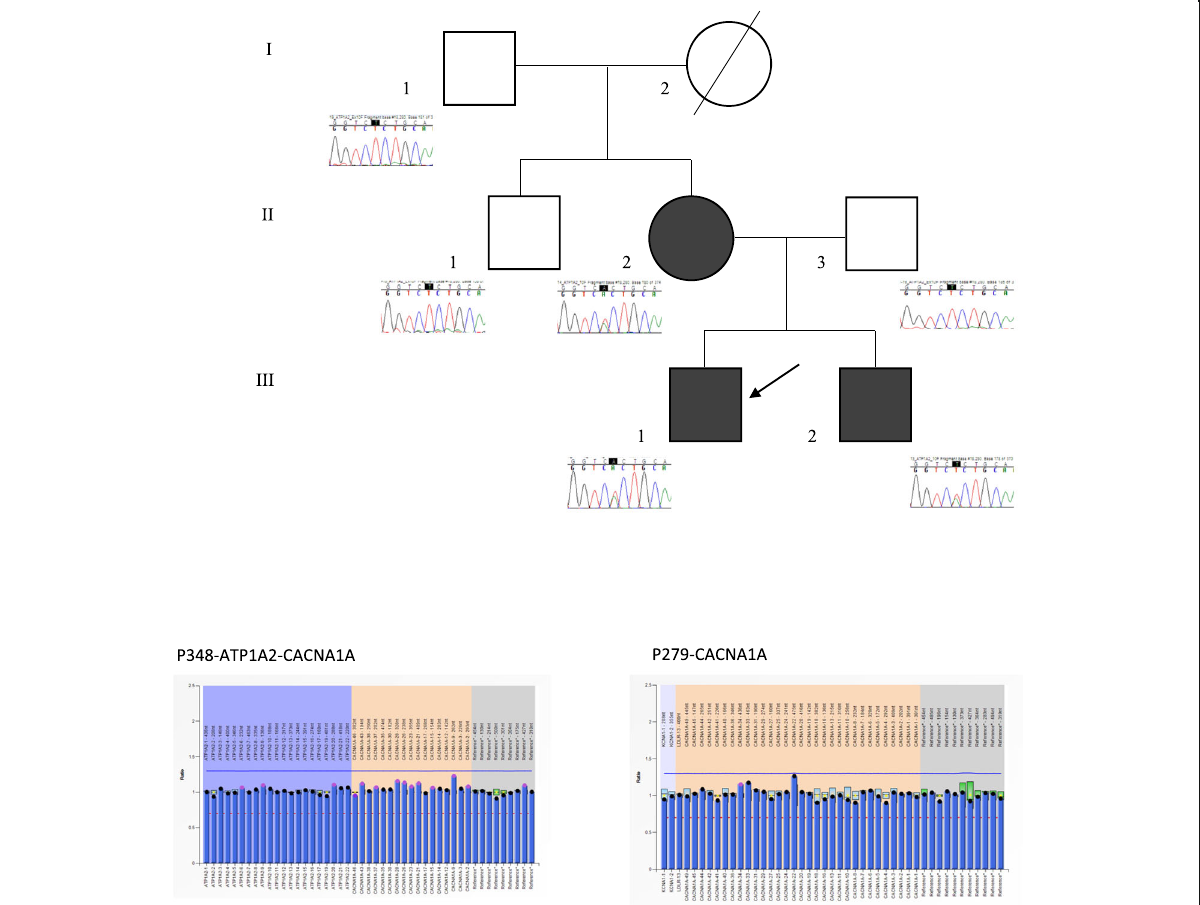
Fig. 1 Pedigree of the family and Sanger sequencing results. Genetic analysis was performed in 6 consanguineous patients of three generations, and revealed a dominant inheritance leading to the missense mutation L425H. Patient I-2 is deceased; she had complained of “ limb paresthesias ” followed by headache in her childhood. All the affected members were symptomatic for sporadic migraine with aura (II-2, III-1 and -2); II-2 and III- 2 also had sporadic episodes of migraine without aura. The proband (III-2) was the only member with an episode of hemiplegic migraine, while the others only showed complex auras (visual, aphasic,